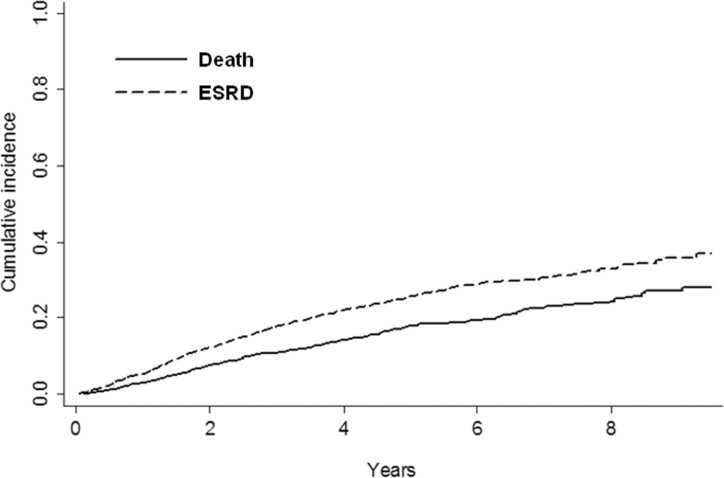
Cumulative incidence probability of ESRD and all-cause death before ESRD, by competing risk analysis, in the whole study population (n = 2340).P <0.0001.